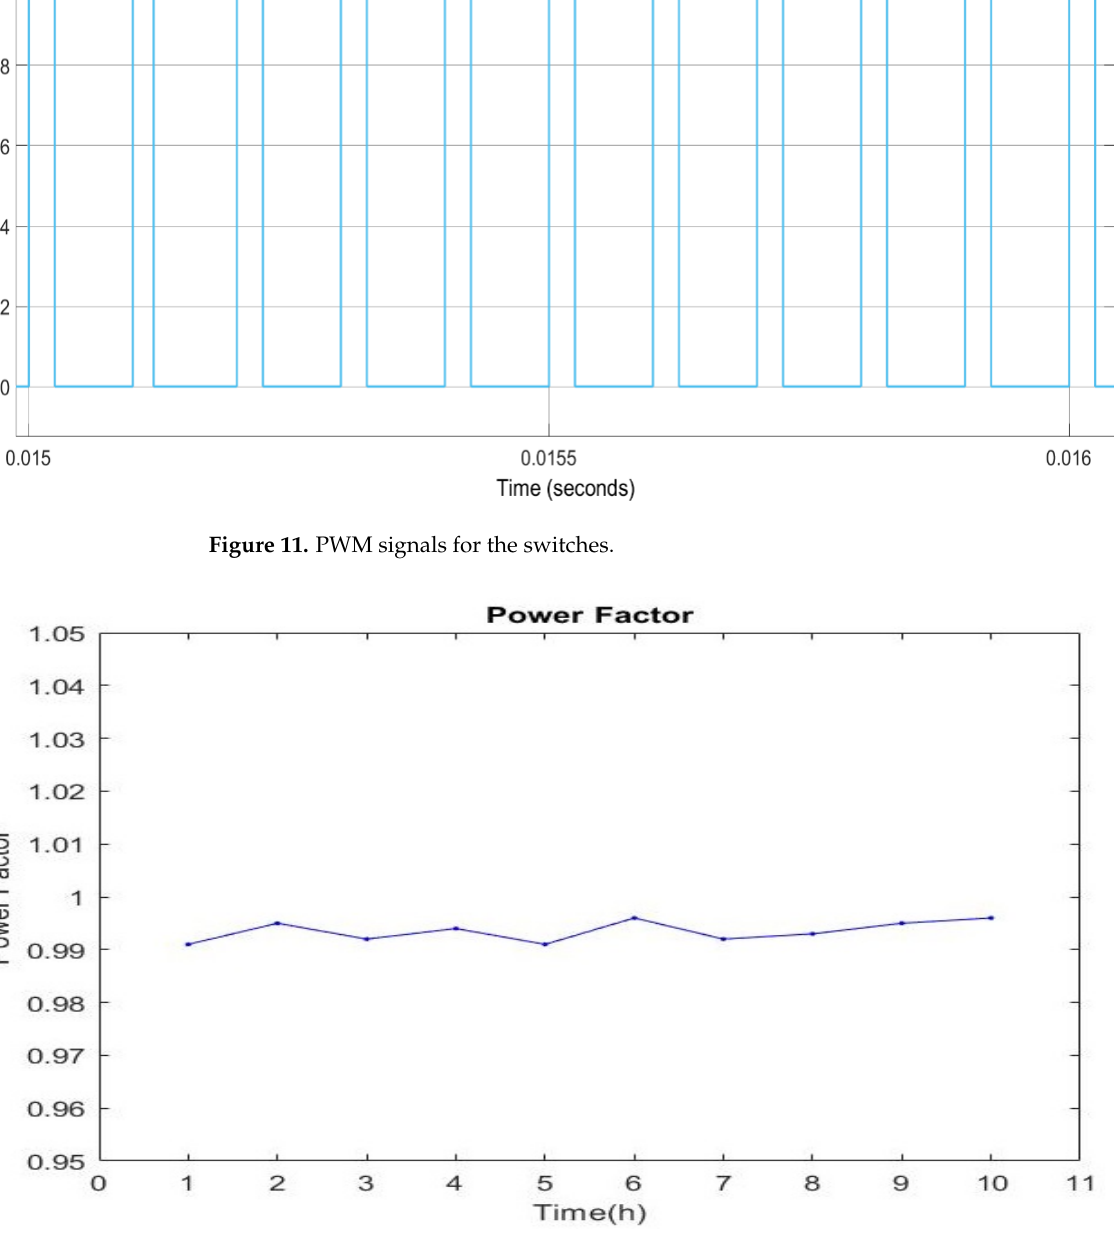
Figure 12. Power factor profile of the system.